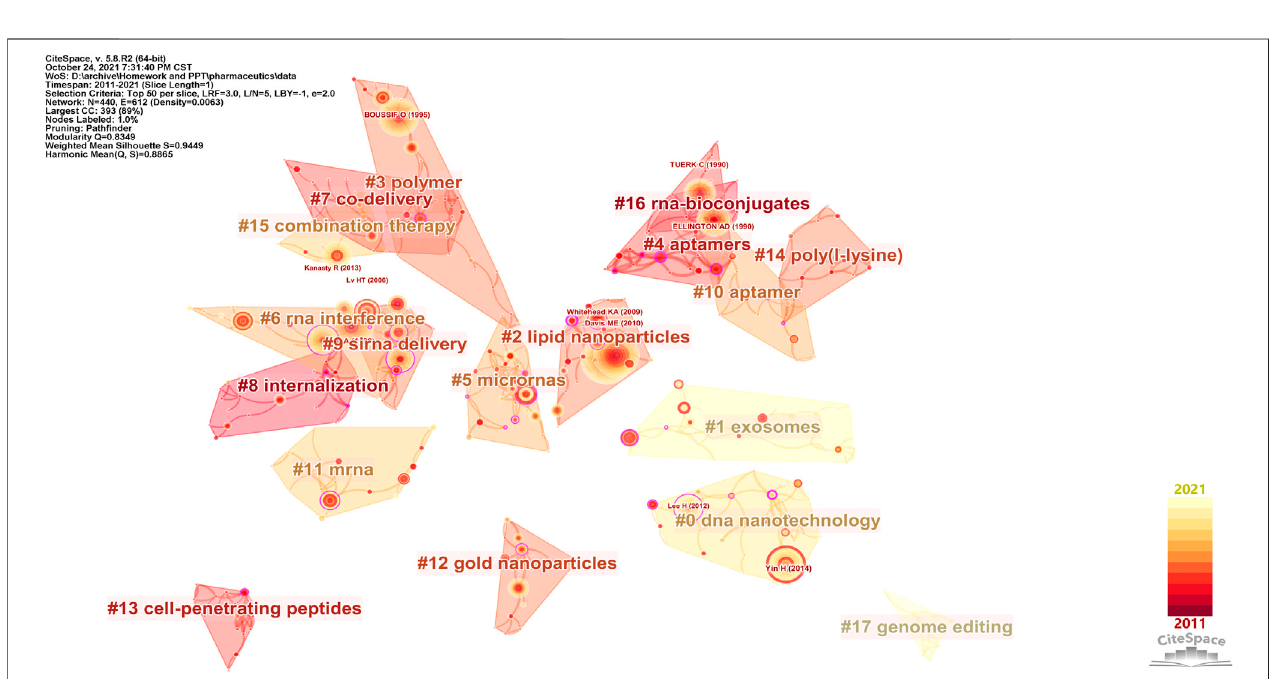
FIGURE 3 | Co-citation network of nanoparticles in nucleic acid – targeted delivery. In this map, the color varied from dark red to light yellow and represented the timeslicefrom2011to2021.Referencesweredrawnasnodeswiththecitationtreerings,andthethicknessofthetreeringswasdirectlyproportionaltothefrequencyof thearticles.Clustersareshownasblockscoloredbytheaveragenumberofcitingyears,numberedbysize(#0=largest,#17=smallest),andlabeledbykeywordsofthe citing articles (log-likelihood ratio).